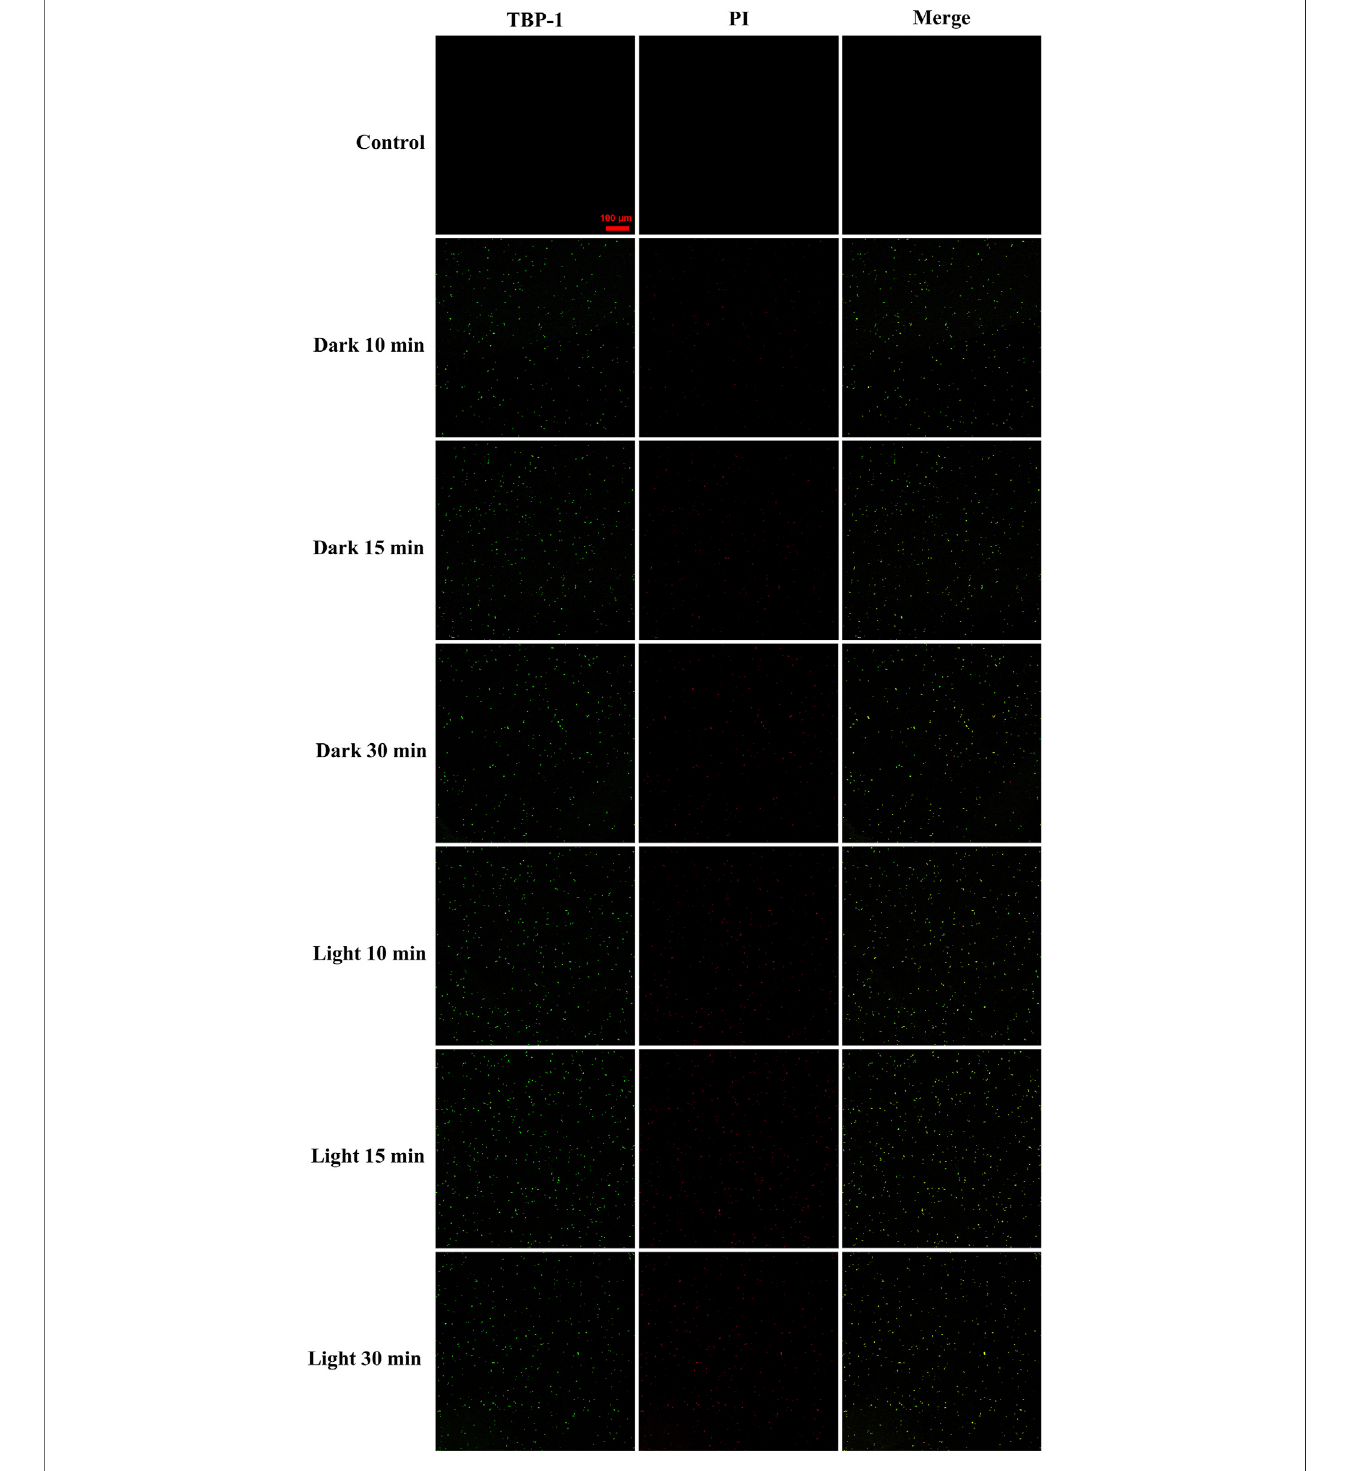
FIGURE 4 | Confocal fl uorescent images of GBS after incubation with TBP-1 (10 µM) and PI as a function of time in the dark or under light irradiation. The fl uorescence of TBP-1 is exhibited in pseudo green and that of DNA stained by PI in apoptotic GBS is exhibited in red. The merged images were used to check the colocalization. The scale bar is 100 μ m. Capture conditions: TBP-1: λ ex (cid:2) 488 nm, λ em (cid:2) 600 – 700 nm; PI: λ ex (cid:2) 543 nm, λ e m (cid:2) 560 – 620 nm.